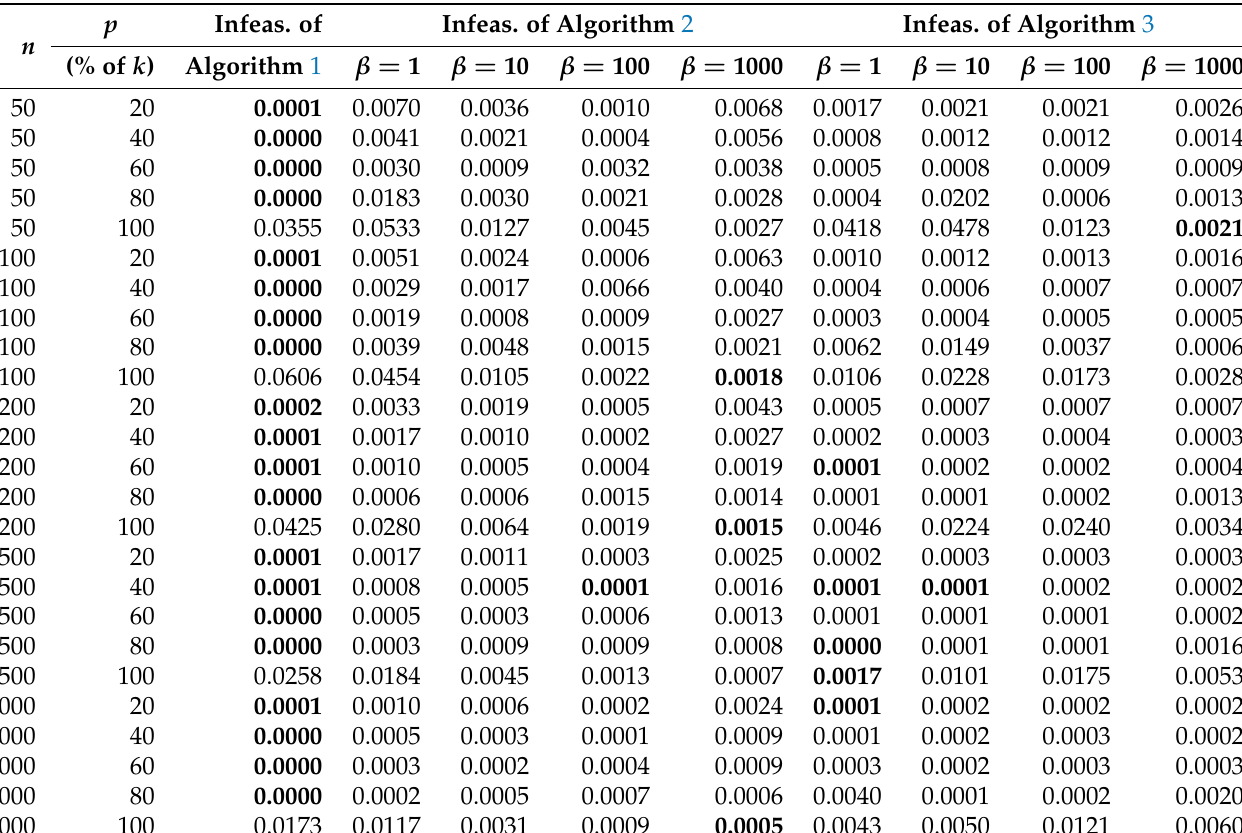
Table 5. In this table we demonstrate how feasible (orthonormal) are the solutions G and H computed by Algorithms 1–3 on the BION dataset, i.e., in this table we report the average infeasibility (18) of the solutions underlying Table 4. We can observe that with these settings of all algorithms we can bring infeasibility to order of 10 − 3 very often, for all values of β . The bold number is the smallest one in each